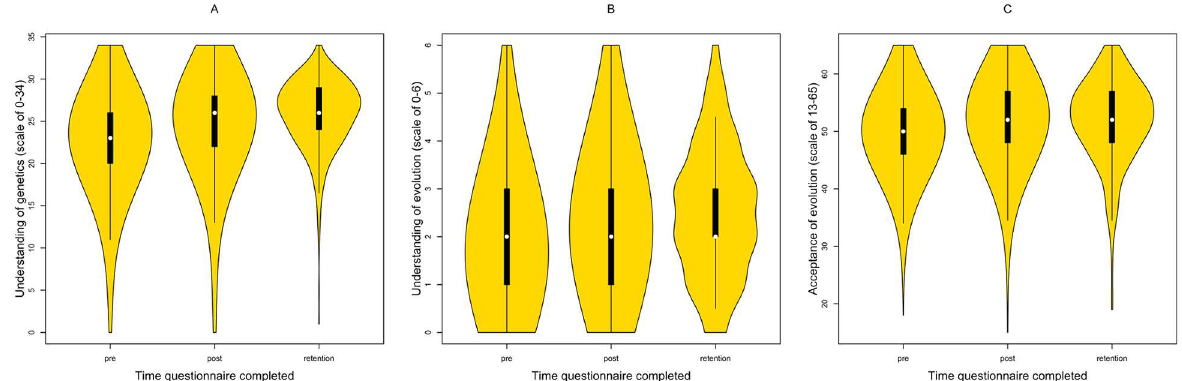
Fig 1. Pre-, post-, and retention test scores for A), genetics knowledge B), evolution knowledge, and C) evolution acceptance (genetics knowledge—pre: n = 388, post: n = 363, retention: n = 329; evolution knowledge—pre: n = 379, post: n = 346, retention: n = 310; evolution acceptance—pre: n = 388, post: n = 365, retention: n = 329). Raw data can be found in S1 and S2